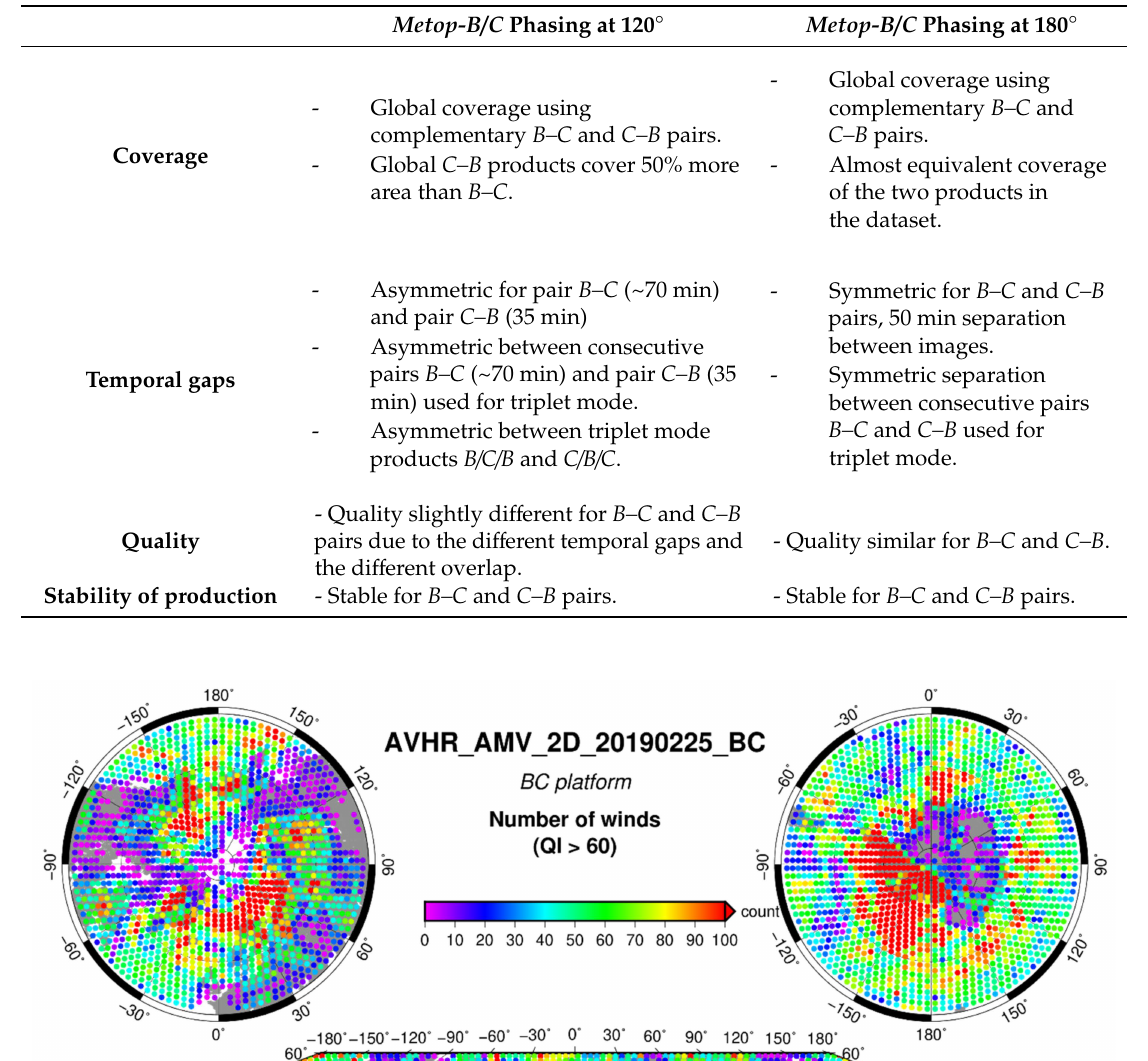
Table 1. Impact of Metop-B / C phasing on dual AVHRR wind products.